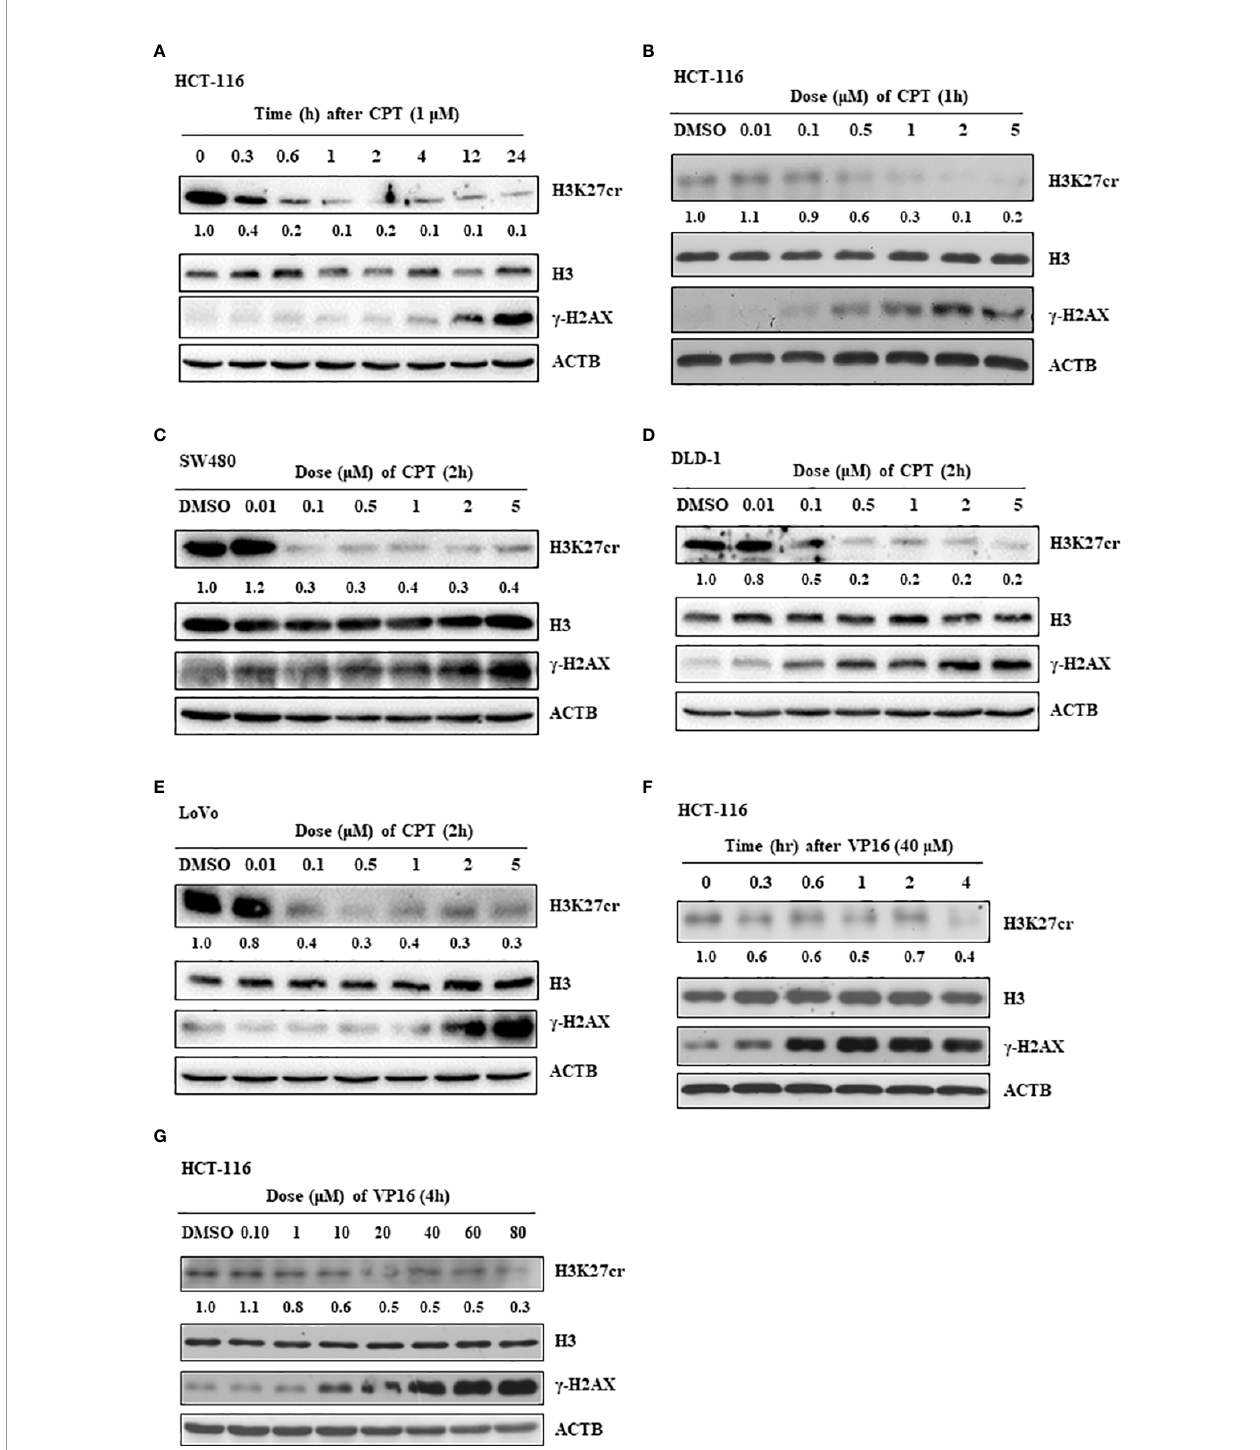
FIGURE 4 | The level of H3K27cr is decreased during camptothecin (CPT) and VP16 treatment. (A) The western blot shows the level of H3K27cr in HCT-116 cells treated with CPT for different periods. (B – E) The western blot shows the level of H3K27cr in HCT-116 (B) , SW480 (C) , DLD-1 (D) , and LoVo (E) cells treated with CPT at different doses, respectively. (F, G) Immunoblotting analysis of the level of H3K27cr in HCT-116 cells treated with VP16 for different periods (F) and at different doses (G) . The ACTB acts as protein loading control. The DMSO acts as a negative control. The numbers under the H3K27cr panel represent the ratio of the level of H3K27cr versus H3 in the treatment group to that in the control group as analyzed by Image J2